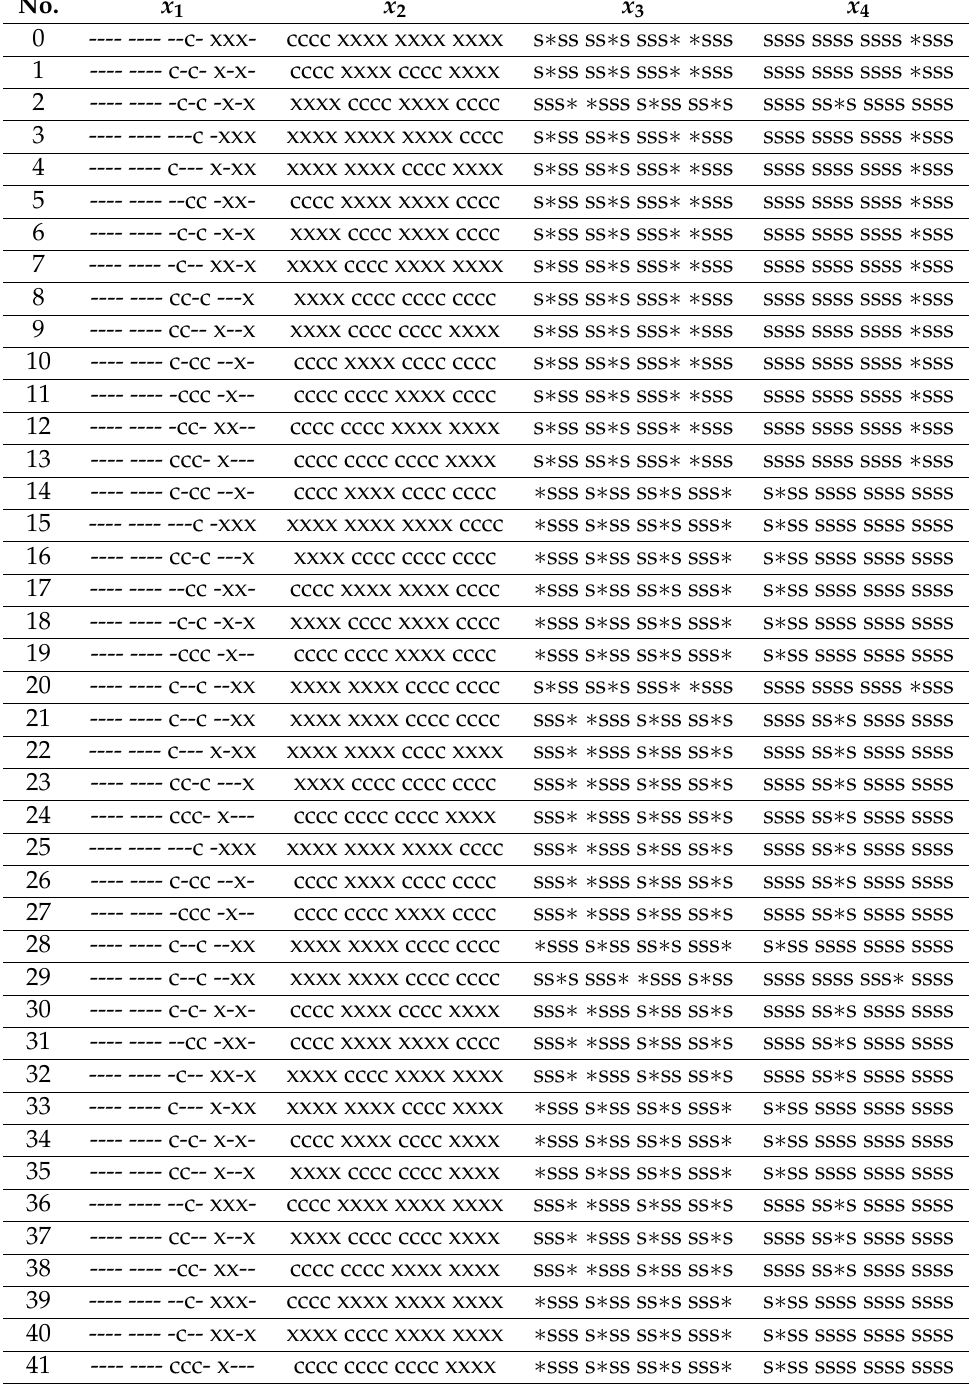
Table A4. Mixture differential trails with probability 2 − 176 for 6-round AES ( x 0 and x 5 to x 6 patterns are the same as those in Figure 3. The signs “ − ", “c", “x", “s" and “ ∗ " represent the inactive, copy, exchange, shift and other quadruple patterns